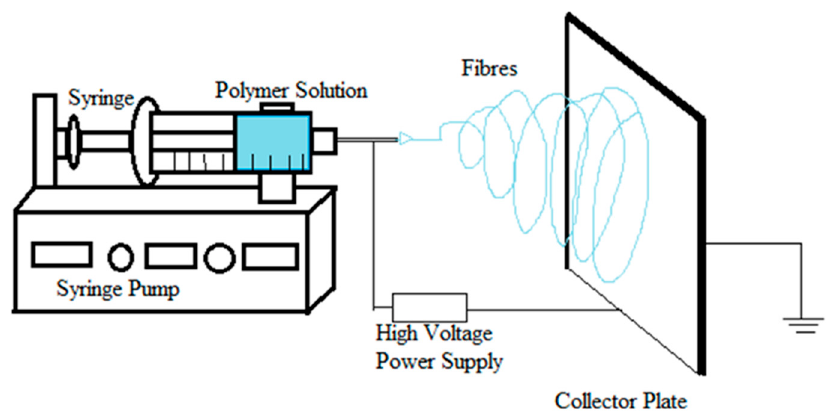
Figure 1. Schematic of electrospinning system. The system consists of polymer solution/melt in a syringe, mounted on a syringe pump, operating at a constant slow speed. High voltage direct current supply is connected to the needle of the syringe to charge the fluid. With sufficient voltage, the fluid forms a Taylor cone and then jet erupts from the cone towards the collector plate with whipping instability.